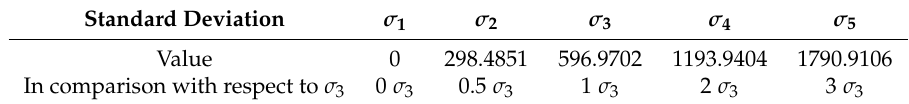
Table 4. Standard deviation’s values and description (own